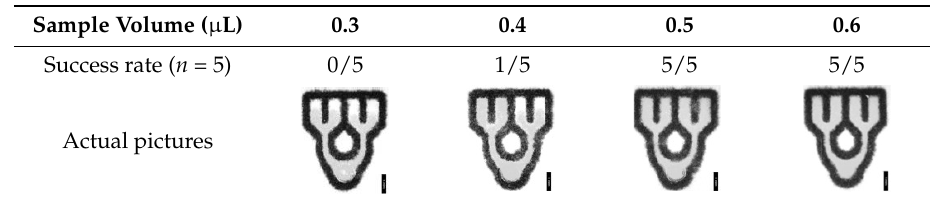
Table 3. Evaluation of the minimal sample volume required to completely fill the model µPAD with multiple detection zones; the scale bars correspond to a length of 1 mm (images converted to grayscale and contrast adjusted for improved visibility).